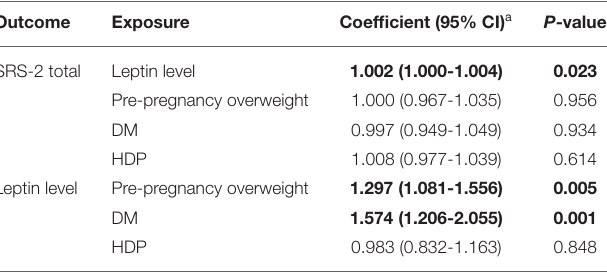
TABLE 2 | Estimated coefficients and p -values in Model 1.